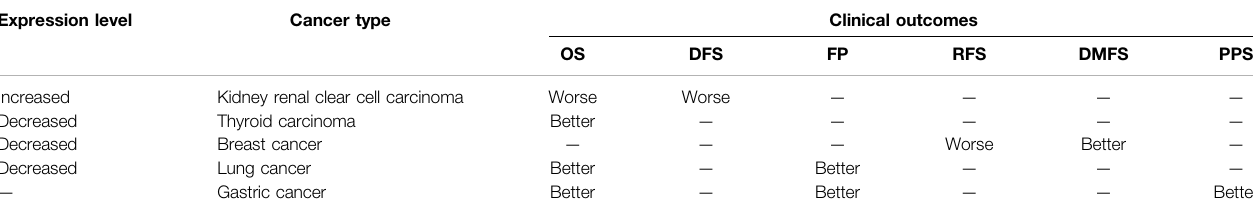
TABLE 1 | Effects of a low KDM6B expression on clinical outcomes in various cancers. The patient samples were divided into two cohorts based on the median expression (high-expression and low-expression group) of KDM6B. The “ Expression Level ” showed the expression difference in tumor tissues and matched normal tissues. Expression